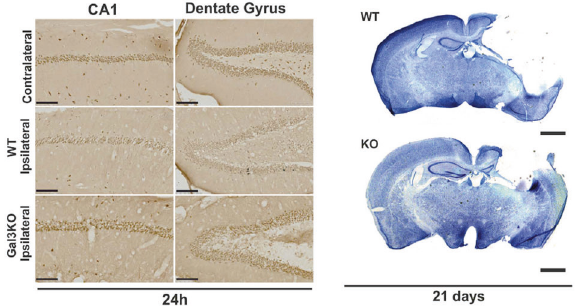
Fig. 3 Illustration from Yip et al. 2017 [14]: effect of the lack of galectin-3 on the neuronal survival in cortex and hippocampus after TBI. Representative pictures of NeuN in different regions (left panel). Representative image of toluidine blue staining in wild-type and galectin-3 knockout mice (right panel). Note neuroprotection at 24 h and limited injury size 21 days after the TBI in Gal-3 KO mice. Scale bars are 100 and 1000 µm